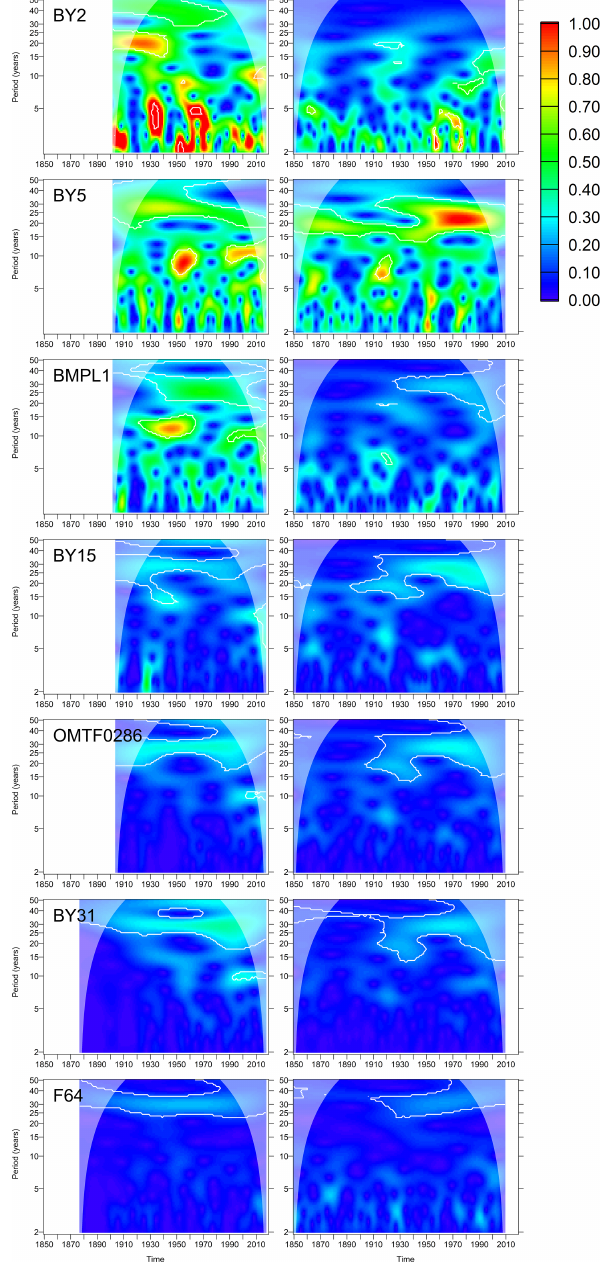
Figure 6. Wavelet amplitudes of surface salinities at selected oceanographic stations (g kg − 1 ). Left column: observations; right column: model results. White contours denote significant ampli- tudes at the 95% confidence level compared to surrogate data ran- domized by shuffling the years.